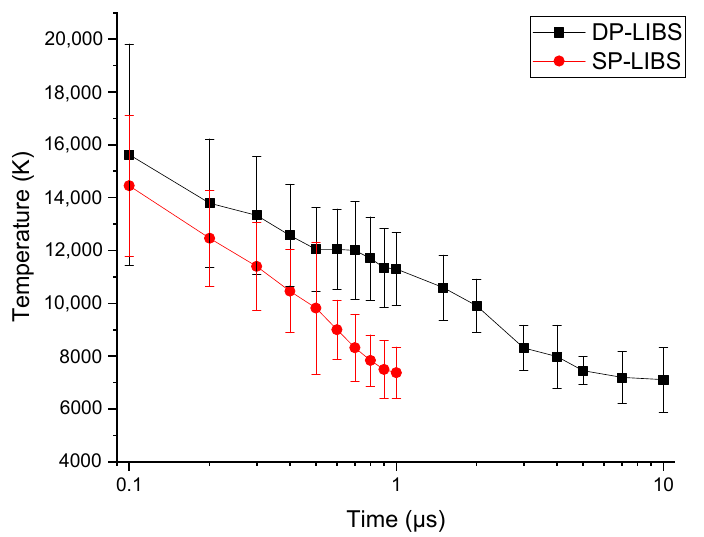
Figure 6. Temporal evolution of plasma temperature, obtained from the multi-element Saha– Boltzmann method. For the DP-LIBS configuration, time zero is defined as the time at which re-excitation occurs.